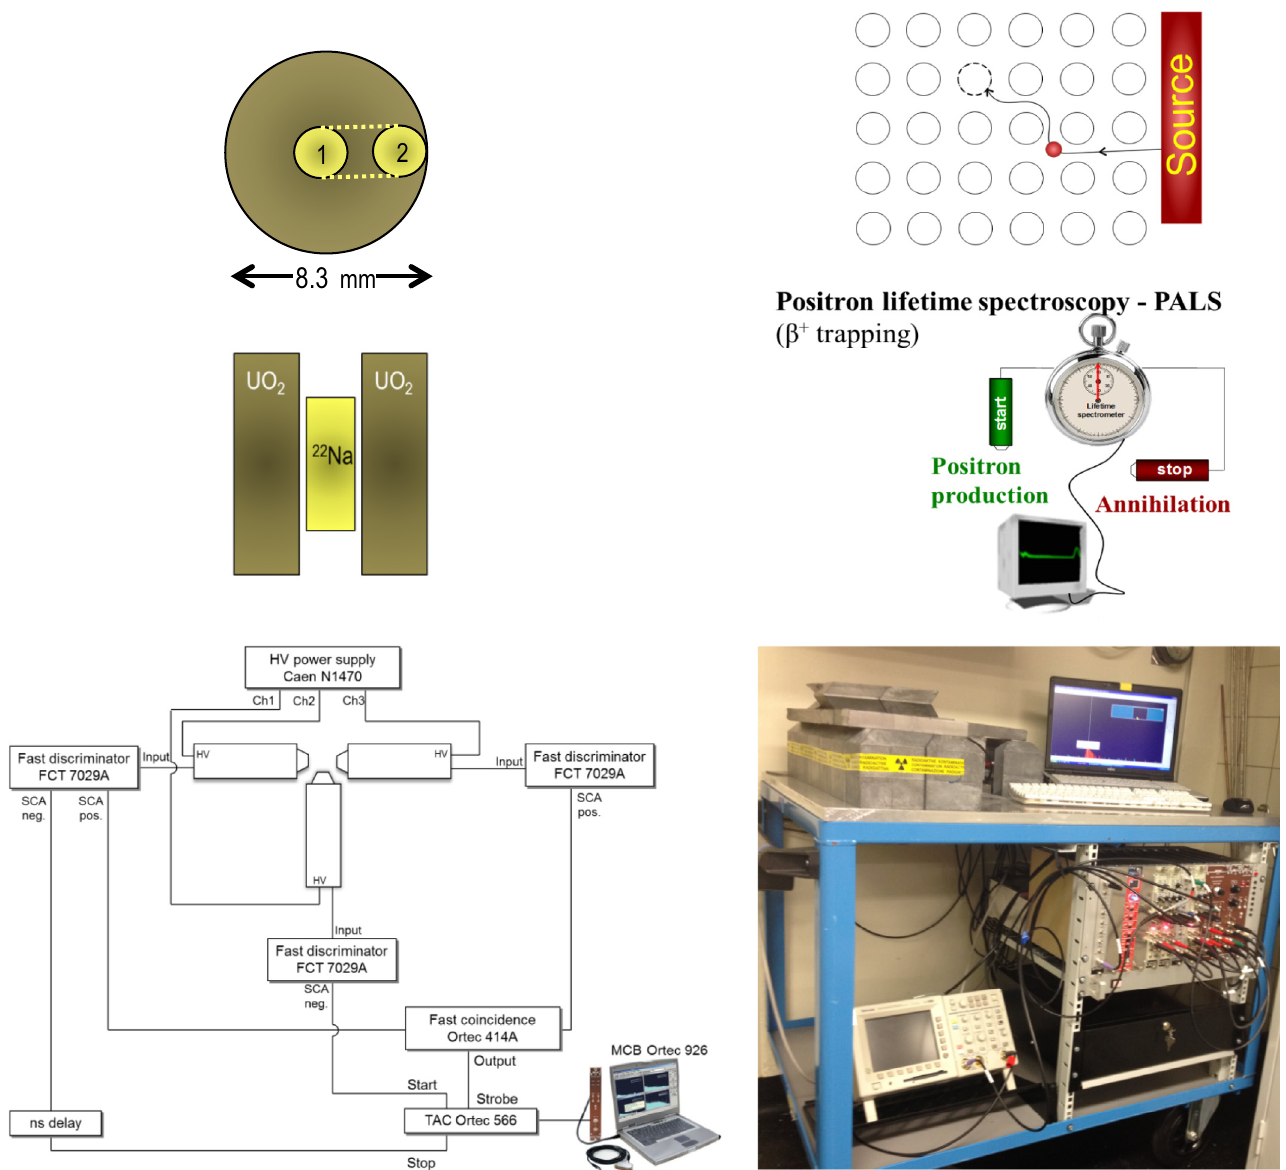
Fig. 1. Schematic drawings of the experimental setup (top and bottom left) and picture of the positron lifetime spectrometer facility (right). In this case, the spectrometer was used in 2-detector mode